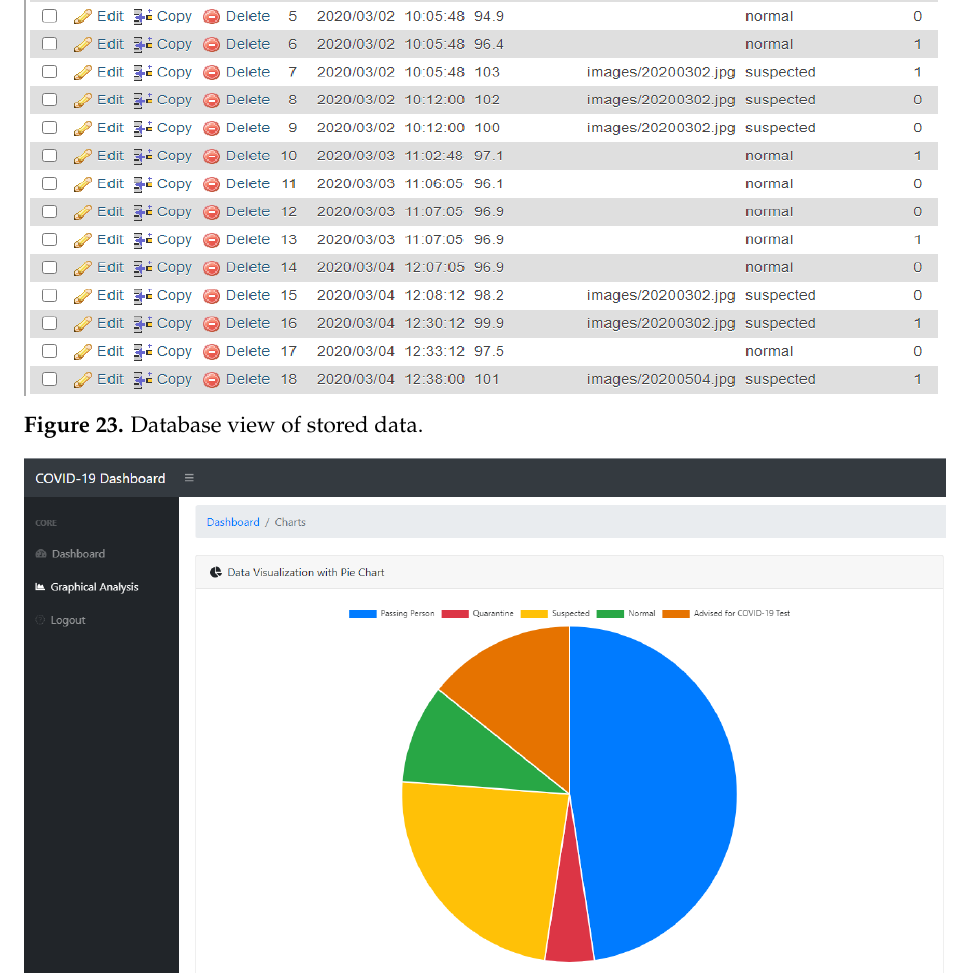
Figure 24. Graph generated by Internet of Things (IoT) web